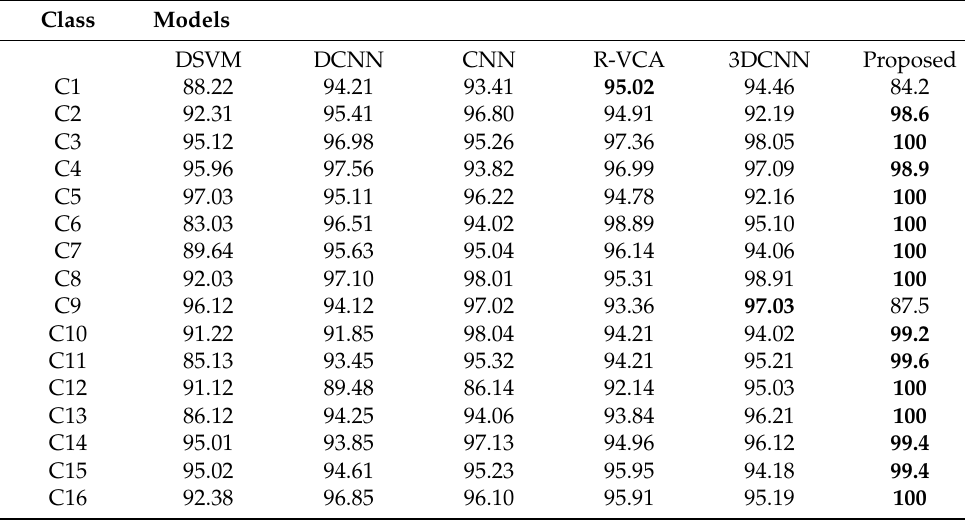
Table 1. Performance by different classes of the Indian Pines